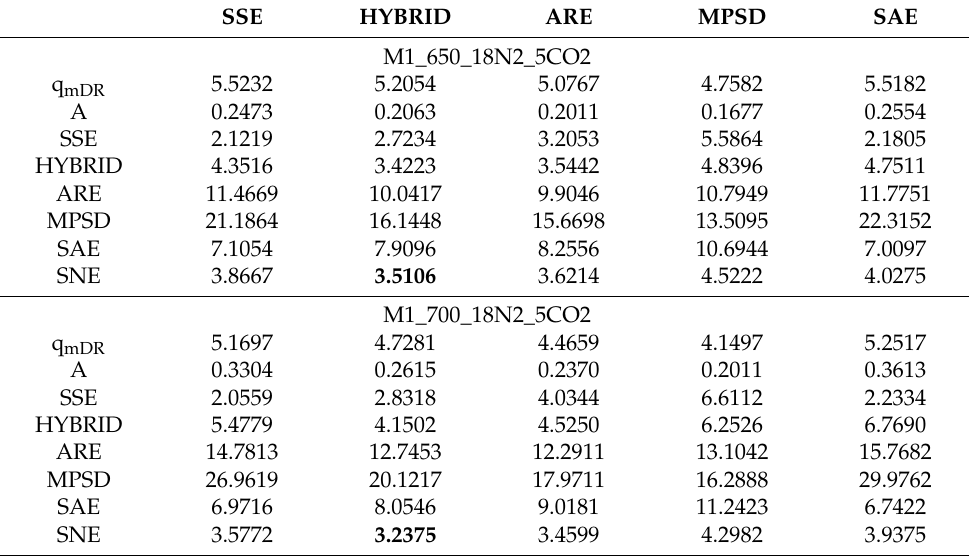
Table 10. Table 10. Dubinin-Raduskevich isotherms constants with error analysis